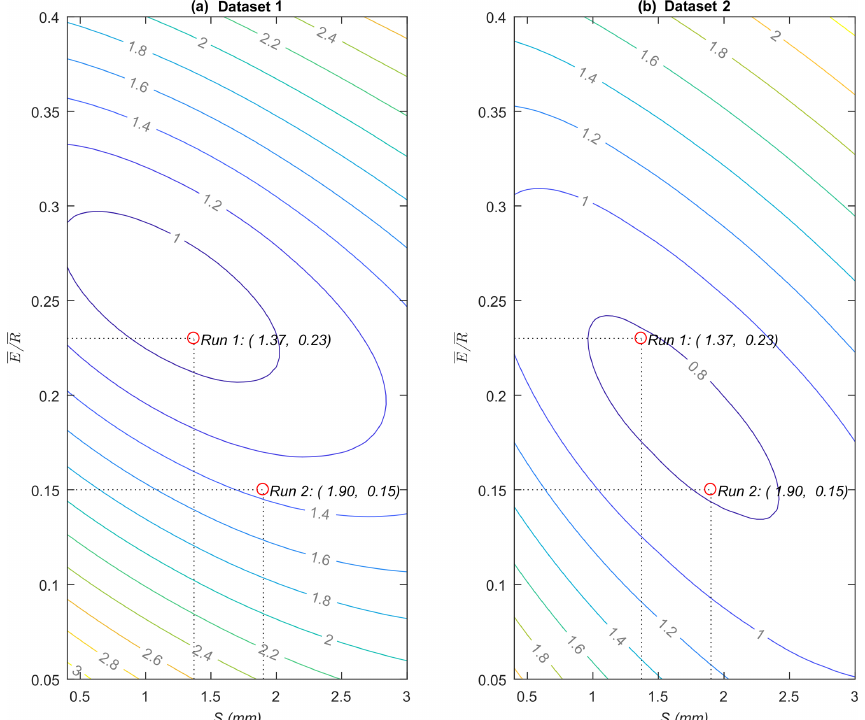
Figure 6. Sensitivity analysis of the parametrized original Gash model. Run 1, all parameters derived from the mean method. Run 2, canopy parameters ( S , p ) derived from IEA and E from the energy balance residual method. Contour lines representing the RMSE for different combinations of the parameters’ canopy storage capacity ( S ) and the ratio ¯ E/ ¯ R . (a) Sensitivity analysis using calibration data-set 1 (19 June to 31 October 2015. (b) Sensitivity analysis using validation data-set 2 (19 June to 31 October 2016). The red circles represent the corresponding parameters used in the model Run 1 and Run